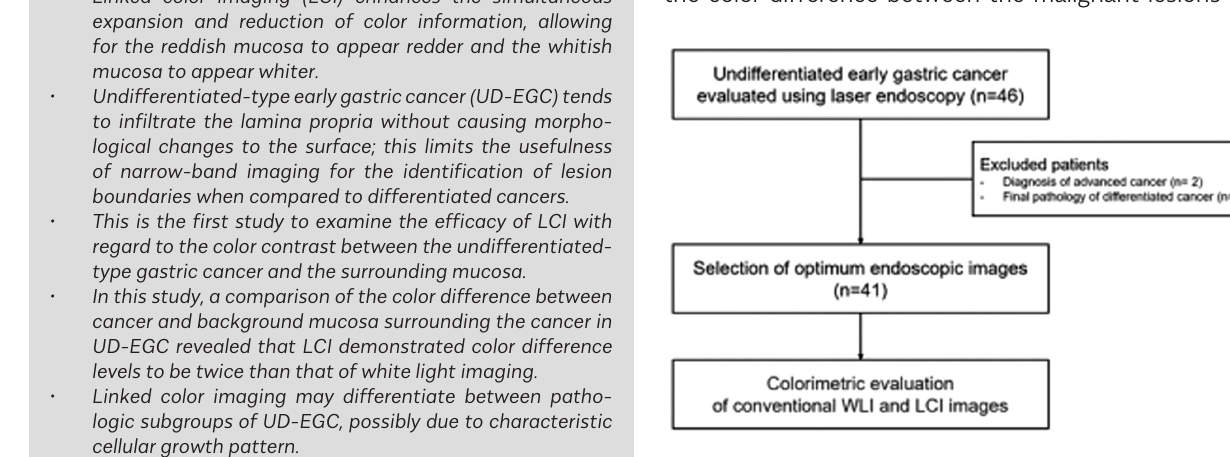
Figure 1. Flowchart of the study